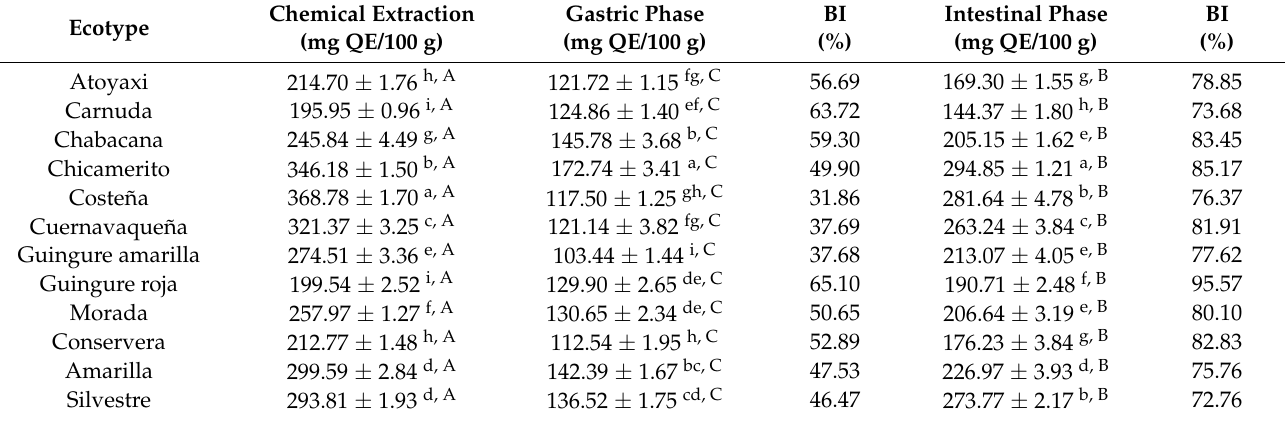
Table 5. Total flavonoid content and bioaccessibility index of 12 ecotypes of S. purpurea L. before and after in vitro